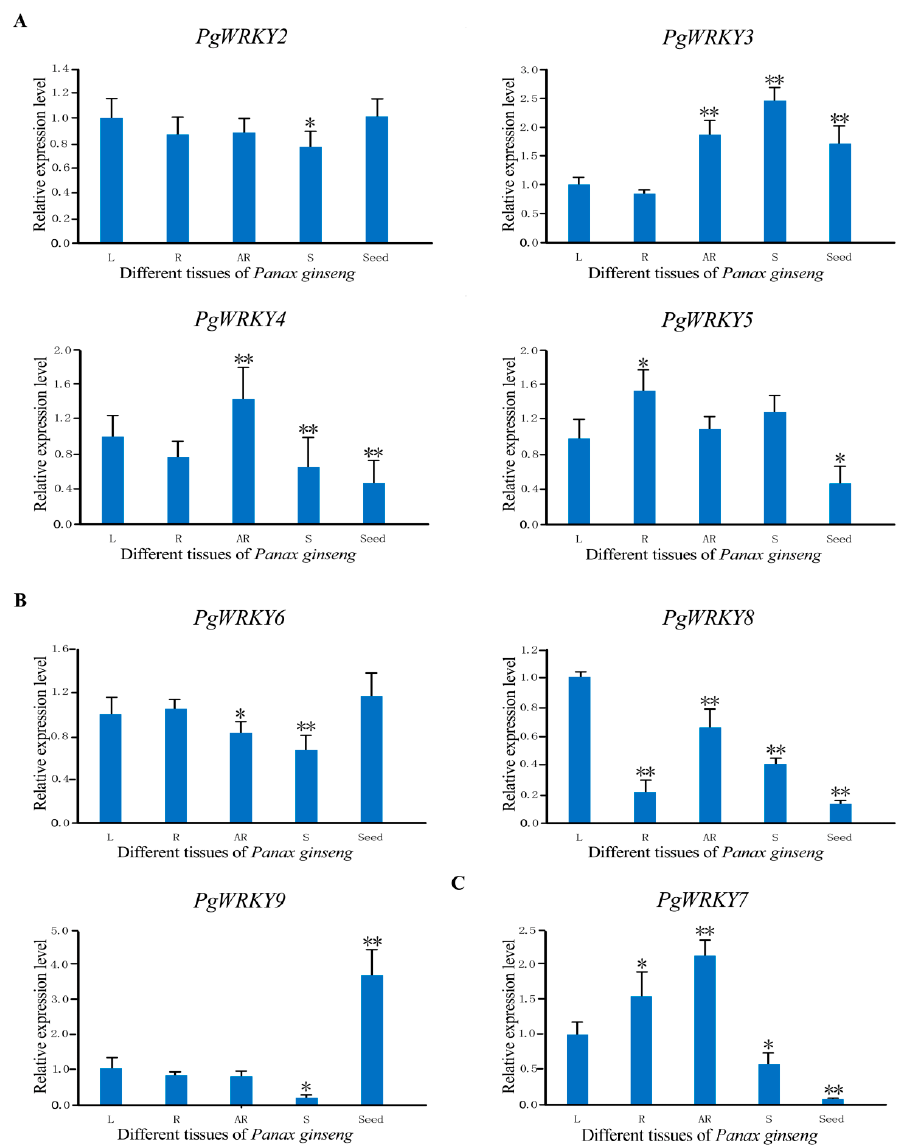
Figure 4. Tissue-specific expression of the eight studied PgWRKYs ( PgWRKY2-9 ) in different tissues of P. ginseng analyzed by qRT-PCR. ( A ) Subgroup II-d; ( B ) Subgroup II-e; and ( C ) Subgroup II-c. L: Leaves, R: Roots, AR: Adventitious roots, and S: Stems. Error bars represent standard deviation (SD) of